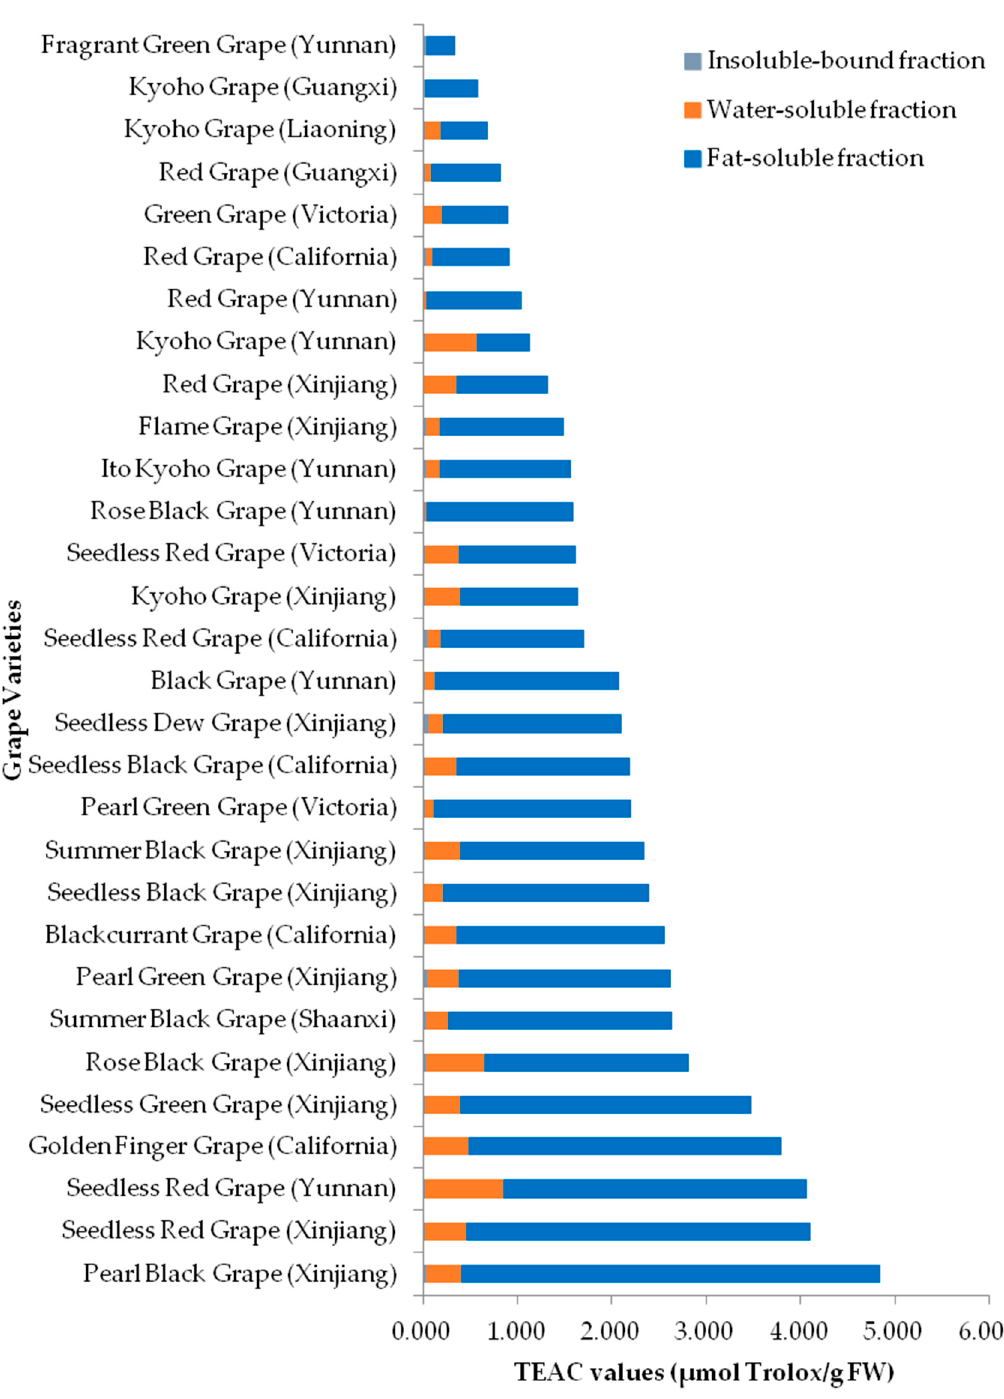
Figure 2. TEAC values of 30 grape pulps.